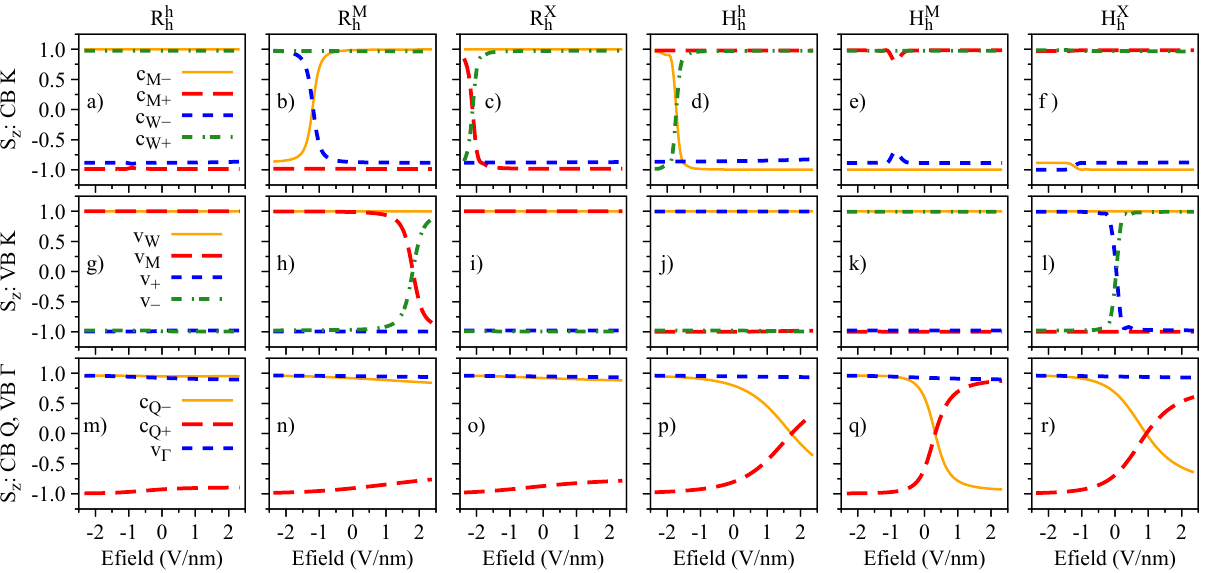
Figure 4. Spin degree of freedom, S z , of the low-energy bands as a function of the applied electric field for the studied stackings R h